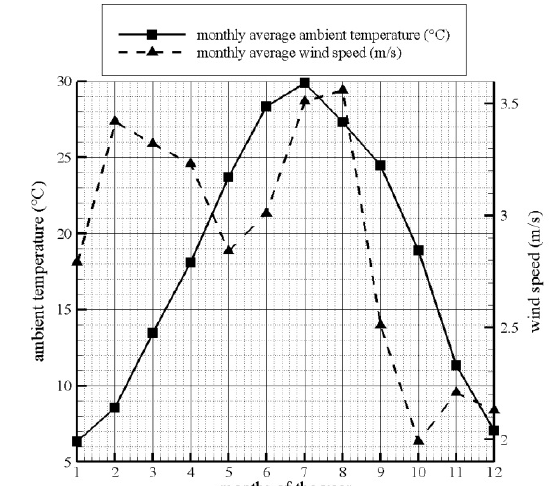
Figure 2. monthly average of ambient temperature and wind speed